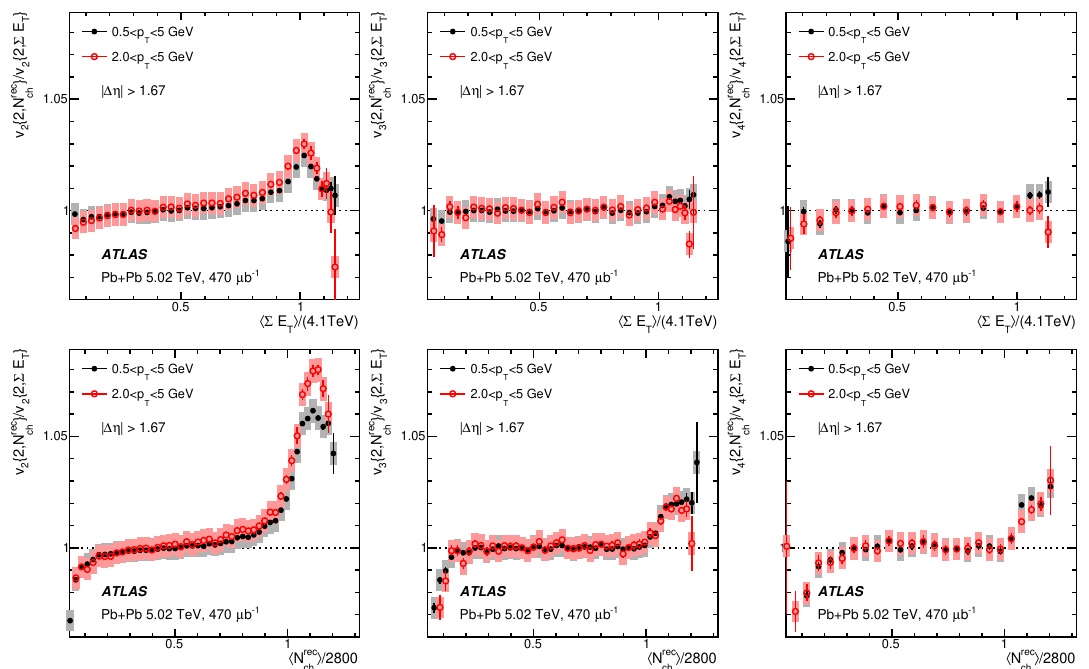
Figure 14 . The ratios of (cid:13)ow harmonics between the two event-class de(cid:12)nitions v n f 2 ; N rec v n f 2 ; (cid:6) E T g as a function of h (cid:6) E T i (top row) and h N rec (middle panel), and n = 4 (right panel) for charged particles in two p T ranges. The error bars and shaded boxes represent the statistical and systematic uncertainties, respectively. Unity is indicated by a dotted line. See text for detailed